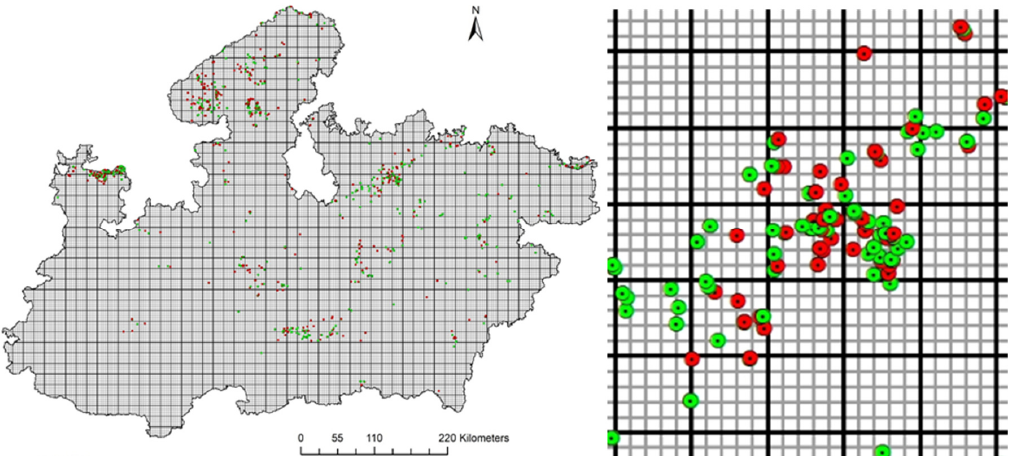
Figure 2. Small area extracted from the state on left is magnified fishnet on the right showing red and green circles are winter and summer sighting points of vultures. Black squares are grids of 250 km 2 and grey squares are sub-grids of 10 km 2 . These grey and black squares are assumed shelter sites and